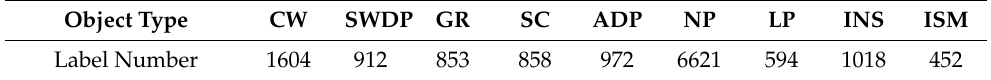
Table 1. The number of objects.